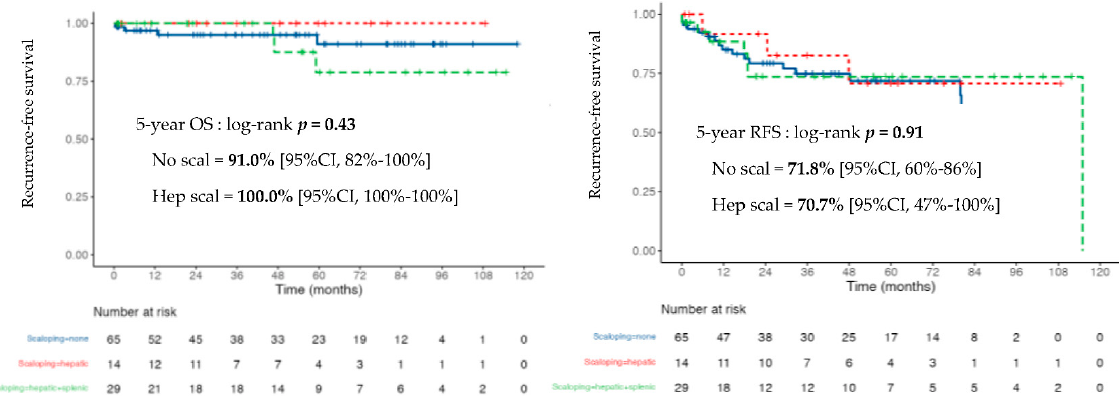
Figure 5. Overall and recurrence-free survival probability in the completely resected population (CC-0/1) by scalloping features.